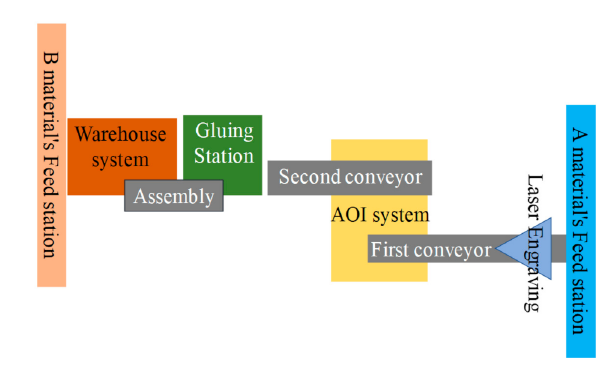
Figure 24. The 2D production-line layout.